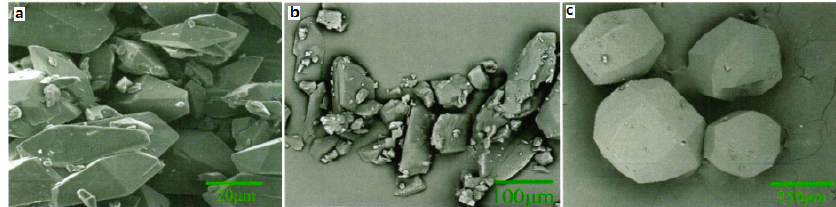
Figure 6. Scanning electron microscope (SEM) photographs of CL-20, TNT and CL-20/TNT cocrystal. ( a ) CL-20; ( b ) TNT; ( c ) CL-20/TNT cocrystal [8], with permission from Han Neng Cai Liao, 2012.